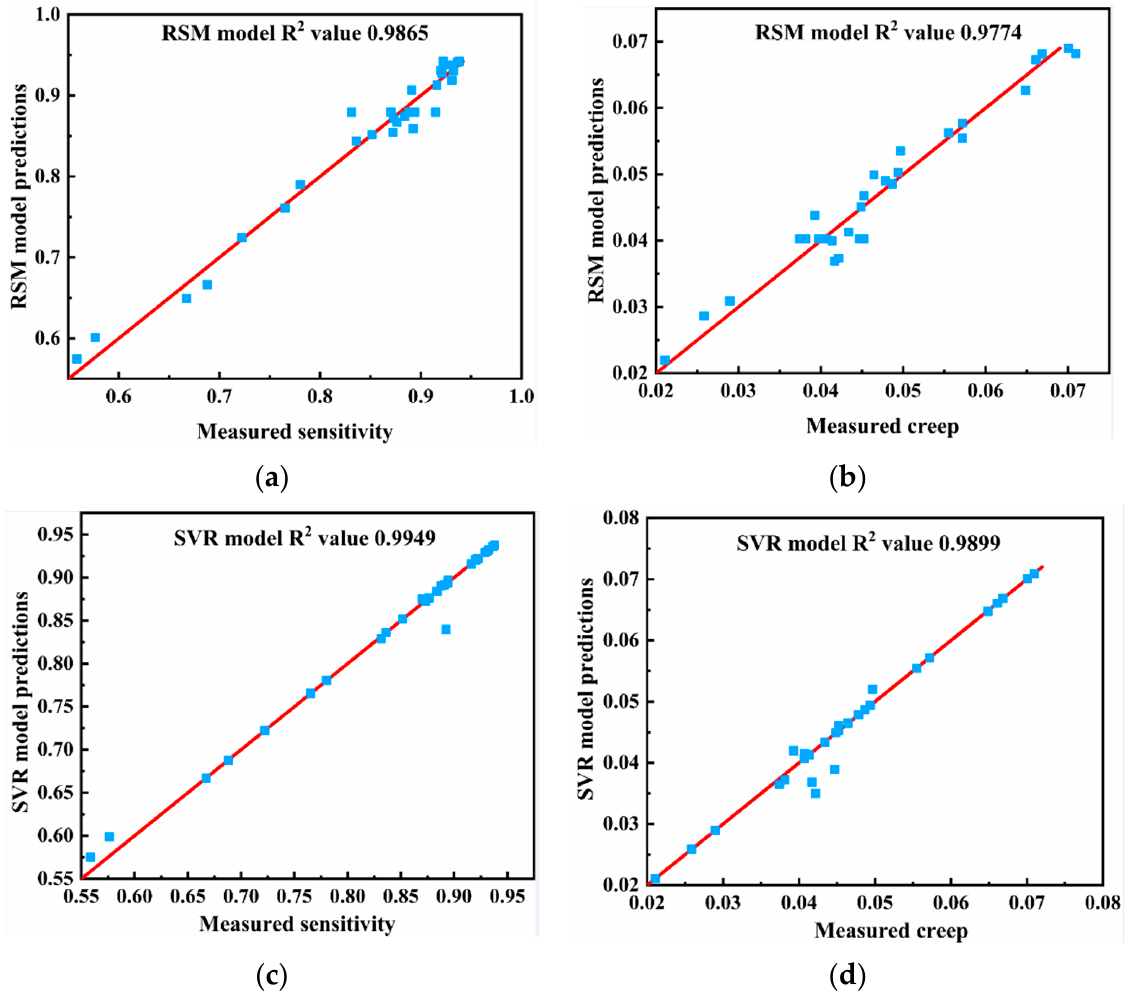
Figure 13. Comparison of the RSM and SVR performances for all data sets, where the red line represents the predicted value and the blue square represents the experimental value. ( a ) Sensitivity results for the RSM model; ( b ) creep results for the RSM model; ( c ) sensitivity results for the SVR model; ( d ) creep results for the SVR model.